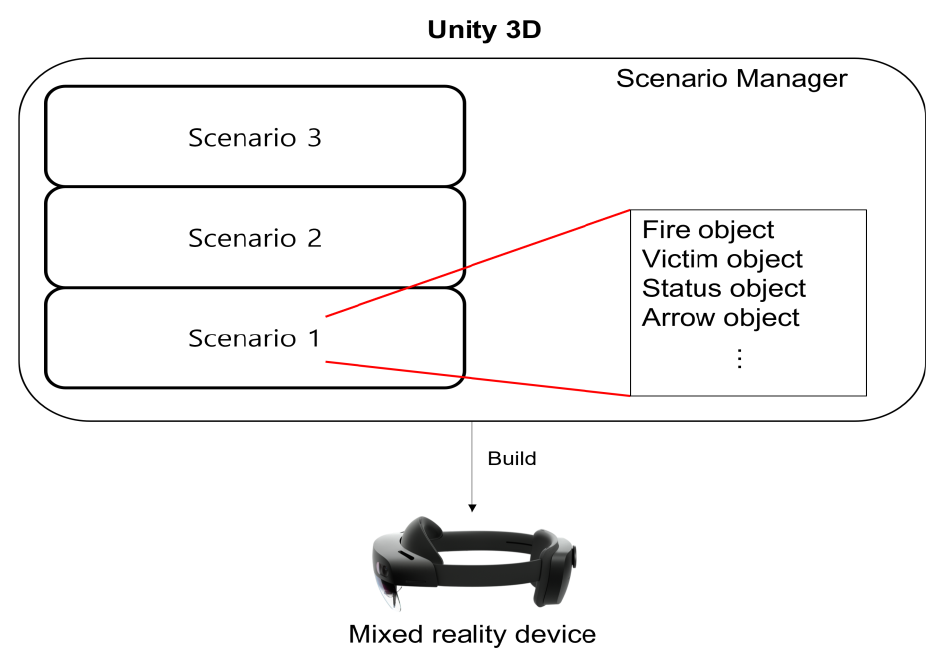
Figure 10. Scenario manager for the MR system.